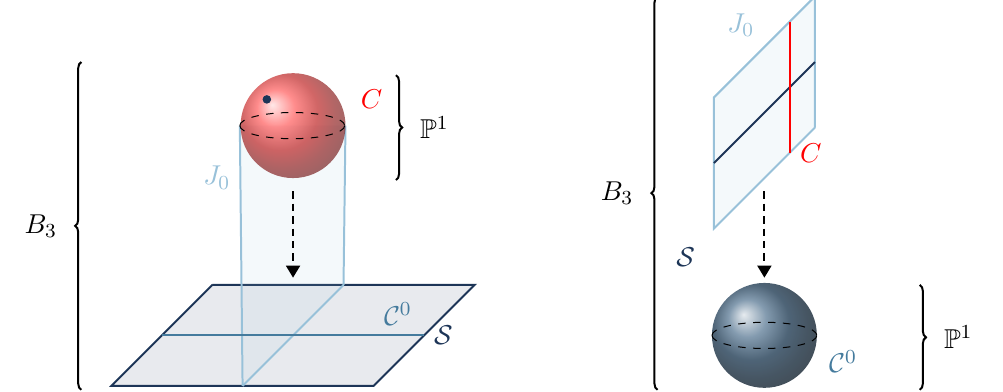
Figure 2. Schematic representation of quasi-primitive EFT strings with q = 0 (figure 2a) and q = 1 (figure 2b). The limits correspond to expanding the base of the rational fibration ( q = 0 ) or of the surface fibration ( q = 1 ). EFT string limits with q = 2 correspond to a homogeneous